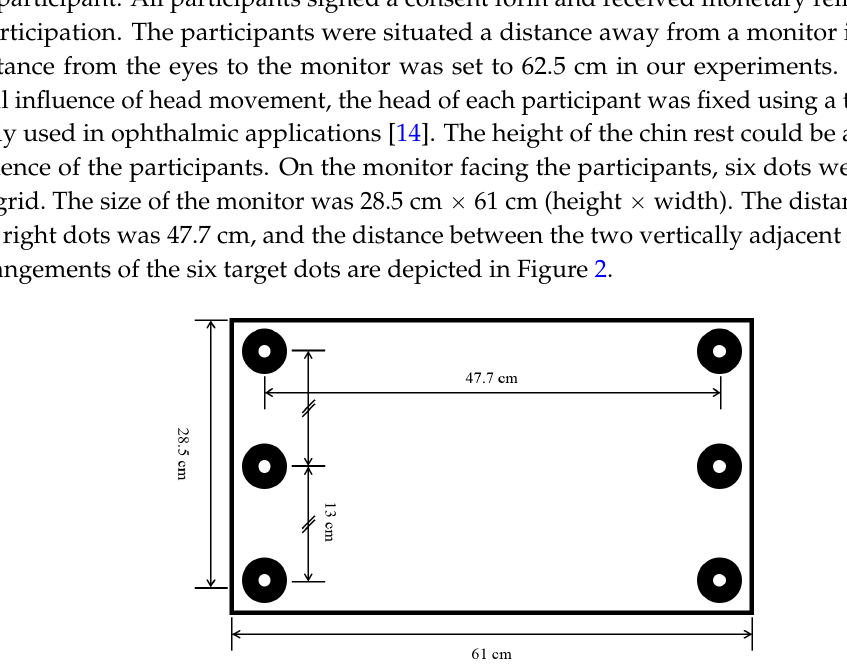
Figure 2. Size of the monitor and six dots arranged in a 3 × 2 grid. The six dots were used as targets for drawing patterns.